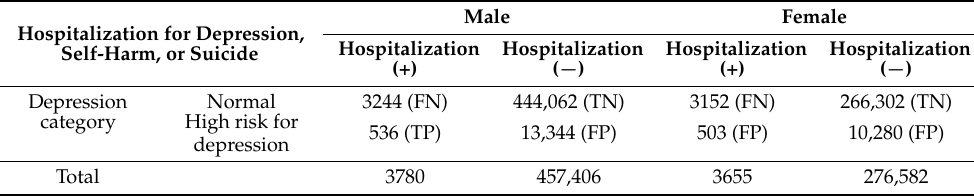
Table 7. Depression screening and distribution of cumulative hospitalizations for depression, self- harm, or suicide.